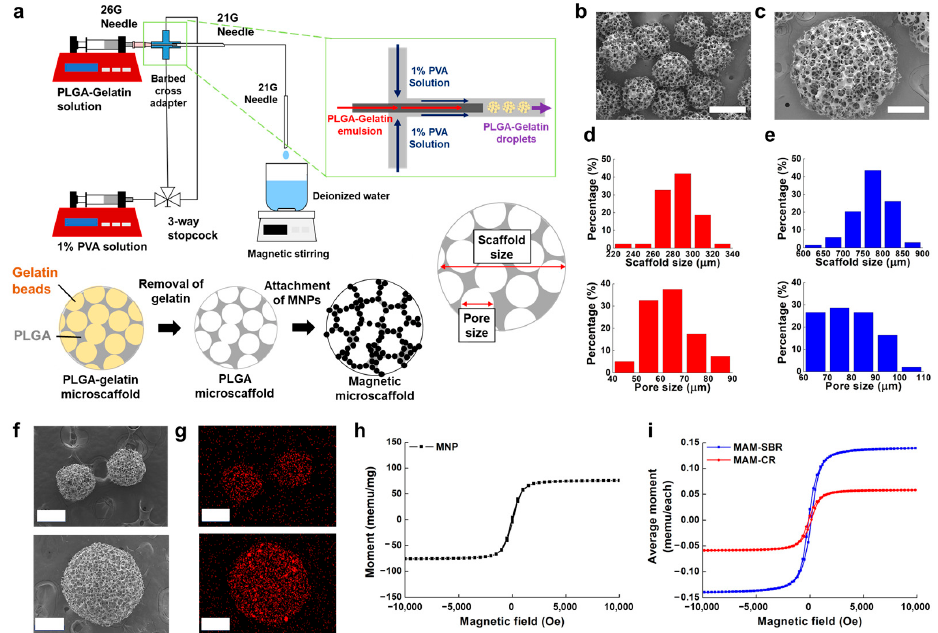
Figure 2. Fabrication and characterization of the magnetic microscaffolds. ( a ) Schematic illustration of the magnetic microscaffolds. SEM images of ( b ) MAM-CR and ( c ) MAM-SBR. Distributions of diameters and pore sizes of ( d ) MAM-CR ( N = 43 ) and ( e ) MAM-SBR ( N = 69 ). ( f , g ) SEM and EDX images of MAM-CR (top) and MAM-SBR (bottom). The scale bars are 250 µm. ( h ) Magnetization curves of MNPs. ( i ) Magnetization curves of MAM-CR and MAM-SBR. To impart magnetic actuation function to the microscaffolds, MNPs were attached to